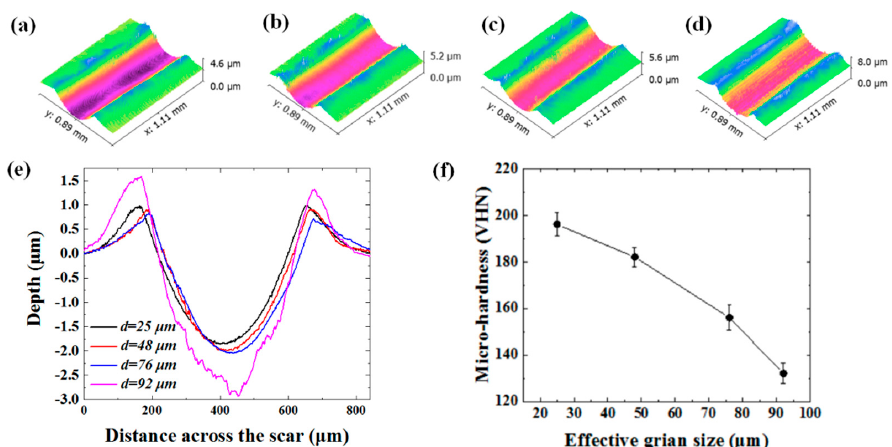
Figure 4. 3-D-surface profiles of the wear tracks of the 304 stainless steel samples with different grain sizes subjected to dry sliding with an applied load of 150 N: ( a ) d = 25 μ m, ( b ) d = 48 μ m, ( c ) d = 76 μ m, and ( d ) d = 92 μ m. ( e ) Cross-sectional profiles of the worn surfaces of the samples with different grain size. ( f ) The variation of surface micro-hardness with effective grain size for the 304 stainless steel samples.